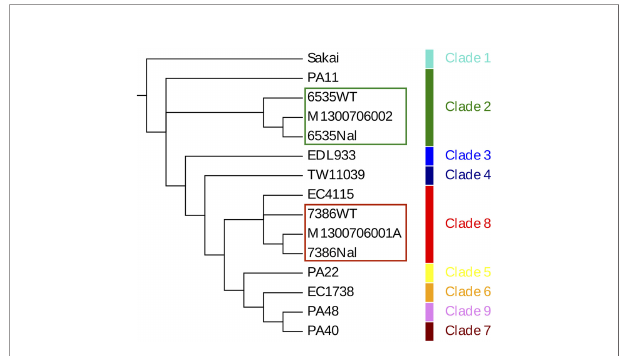
FIGURE 1 | Whole genome phylogeny of representative EHEC O157:H7 strains Genomes of a total of 15 E. coli strains were aligned using Mugsy (Angiuoli and Salzberg, 2011) and included wt /NalR laboratory strains 7386 and 6535 and two clinical strains recovered from the patient and were complemented by representative isolates in the stepwise evolutionary model of EHEC O157:H7 (Feng et al., 2007; Manning et al., 2008).The phylogenetic tree was constructed using RAxML (Stamatakis, 2014) with 100 bootstrap replicates and decorated with the strain-associated metadata in Evolview (He Z. et al., 2016). Bootstrap values below 100 are shown in the